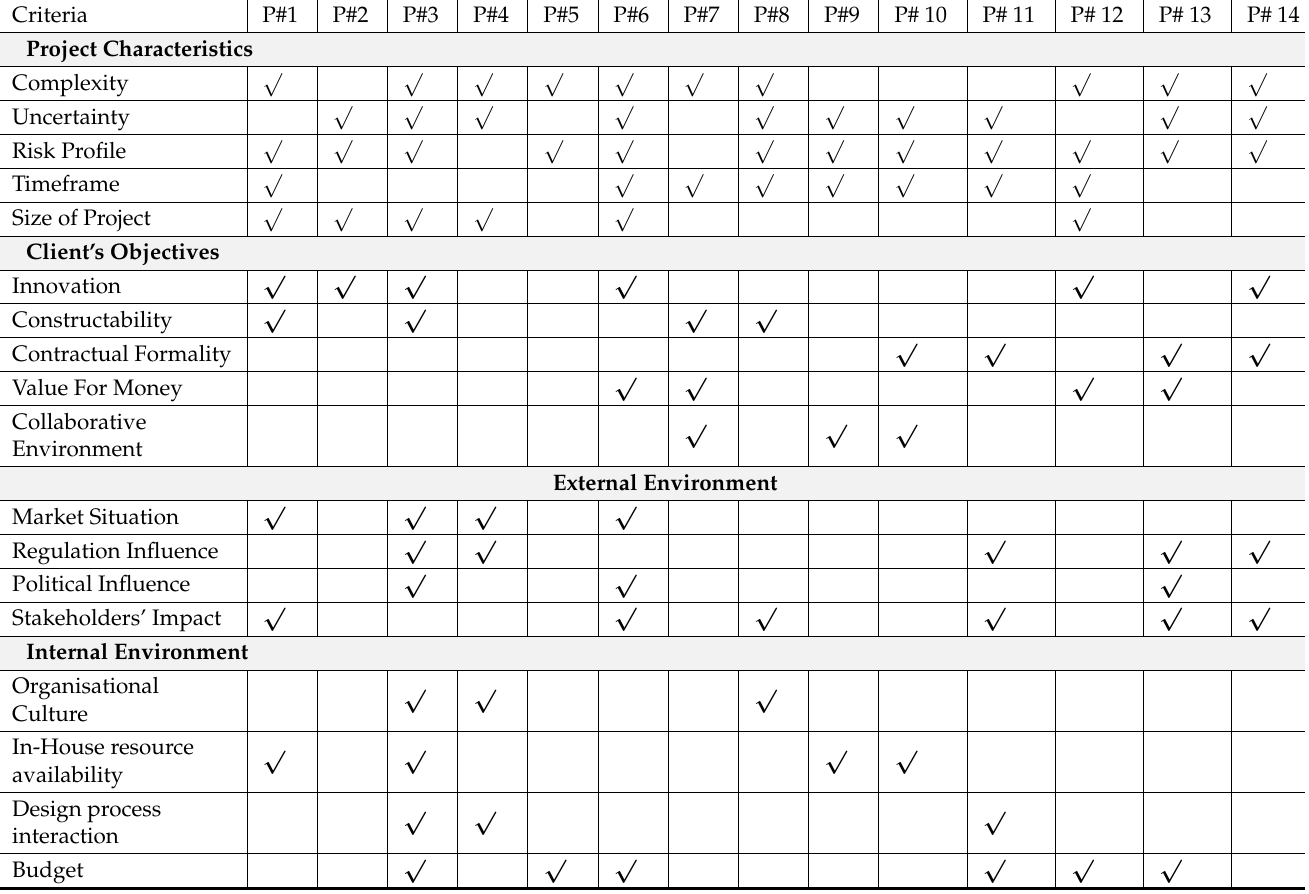
Table 2. Underlying criteria influencing the selection of